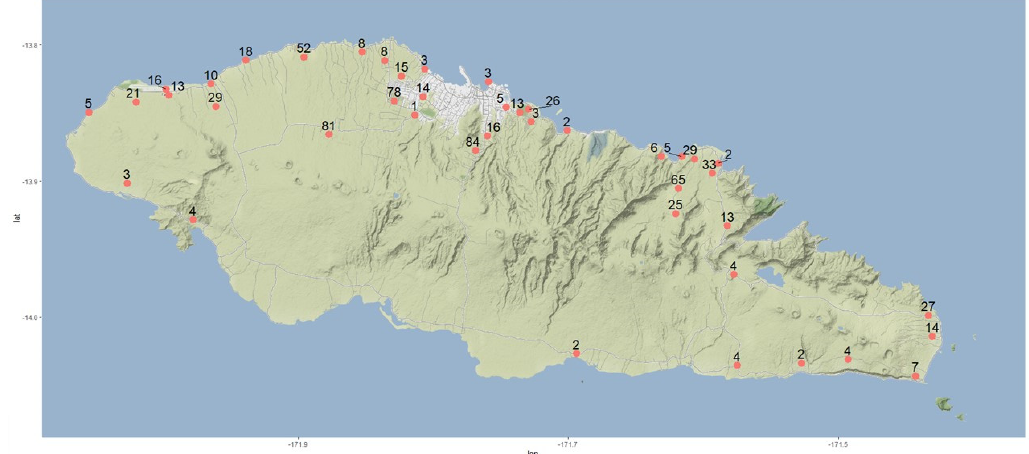
Figure 4. CRB ( Oryctes rhinoceros ) monitoring sites in Upolu, Samoa. Red dots indicate the trap location with trap catch numbers from individual traps indicated. Longitude values are shown on the x-axis and the latitude values on the y-axis.